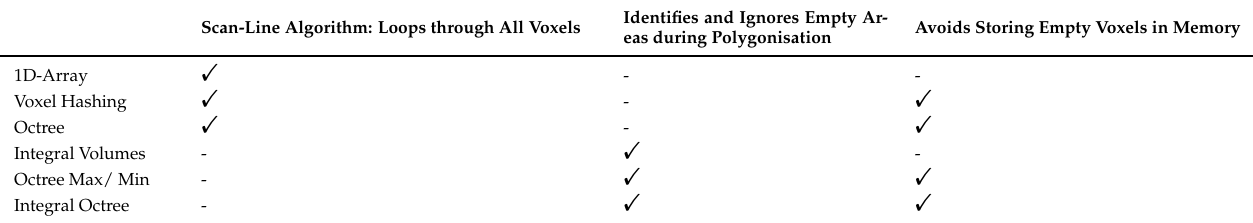
Table 6. Summarising the addressed challenges and the properties of all the data structures implemented. Scan-Line Algorithm: Loops through All